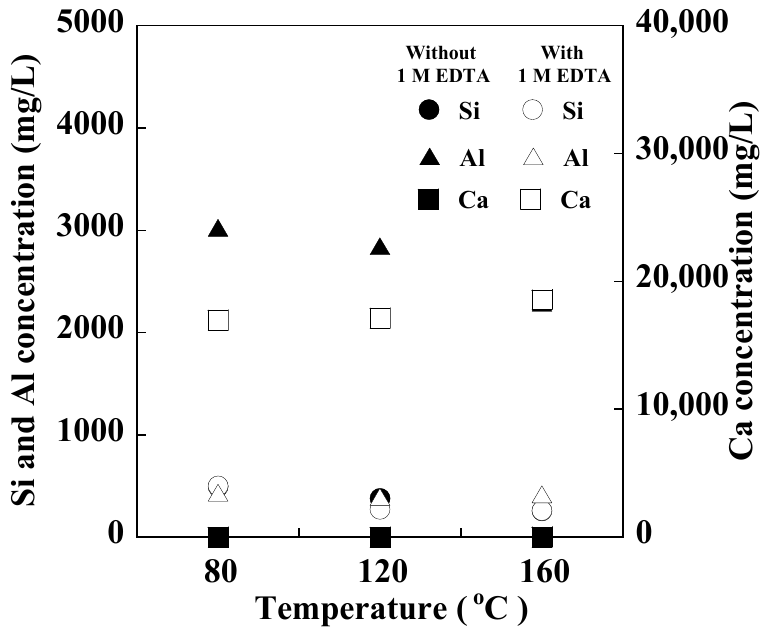
Figure 5. Concentrations of Si, Al, and Ca in the solutions after synthesis at 80, 120, and 160 °C (NaOH concentration: 3 M NaOH, Reaction time: 24 h).